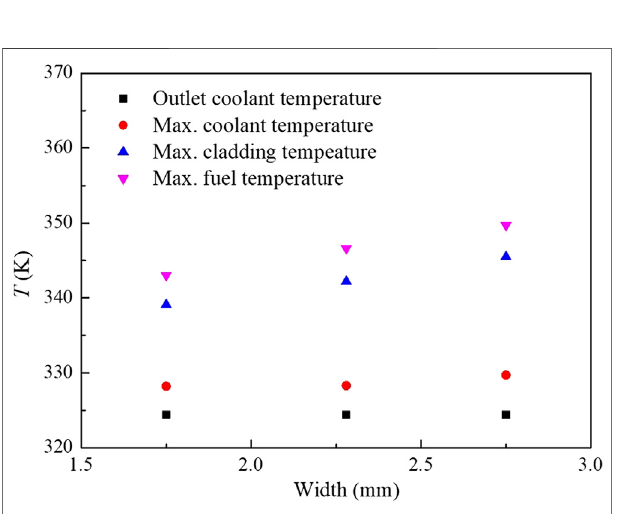
FIGURE 13 | Temperature of coolant, cladding and fuel with different channel widths.